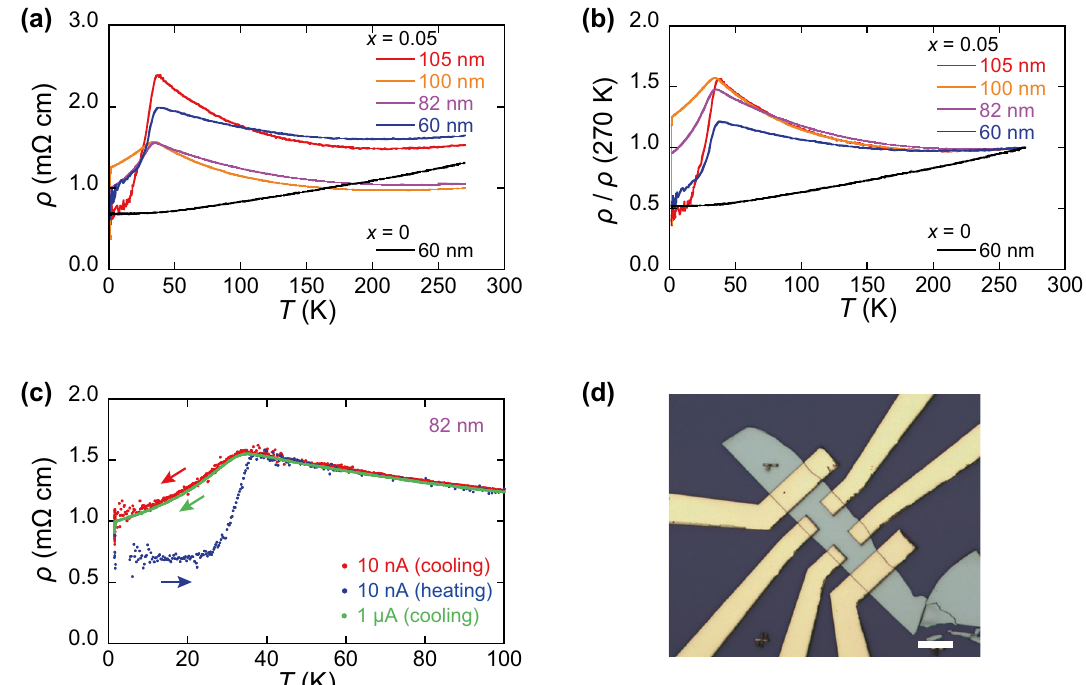
Figure 1. Temperature dependence of ( a ) resistivity and ( b ) normalized resistivity at 270 K of Ag x Bi 2 Se 3 ( x = 0.05 and 0) with various thicknesses. Resistivity is measured in the cooling process. The data from devices of 105 and 60 nm thicknesses were used in our previous report 19 . ( c ) Hysteretic behavior of resistivity observed in Ag 0.05 Bi 2 Se 3 with 82 nm thickness. Resistivity measured during the cooling and heating processes is indicated by the directions of arrows. ( d ) Optical microscope image of a sample with 100 nm thickness. Scale bar indicates 10